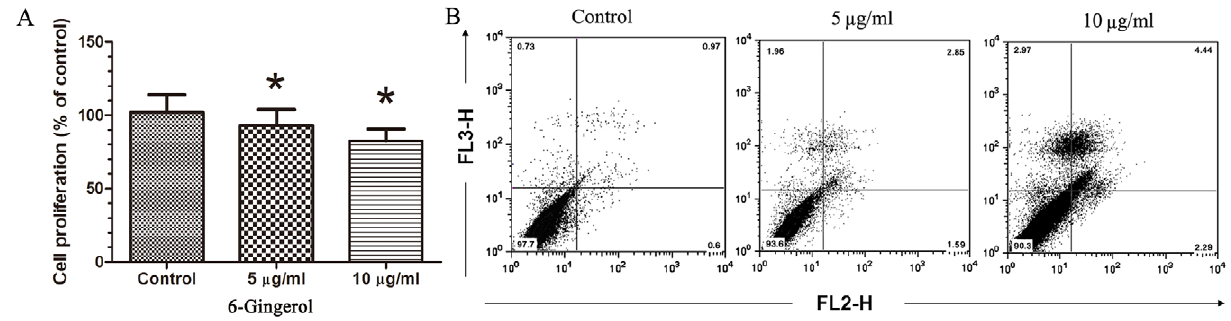
Figure 1. Growth inhibition and induction of apoptosis effects of 6-gingerol on human DPCs invitro. DPCs were cultured with different concentrations of 6-gingerol for 48 h. Compared to the vehicle-treated control, treatment with 10 m g/ml 6-gingerol significantly inhibited the proliferation of cells. (A) Cell viability was determined by the MTT assay. * P , 0.05 vs the vehicle-treated control. (B) Apoptosis analysis of cells.